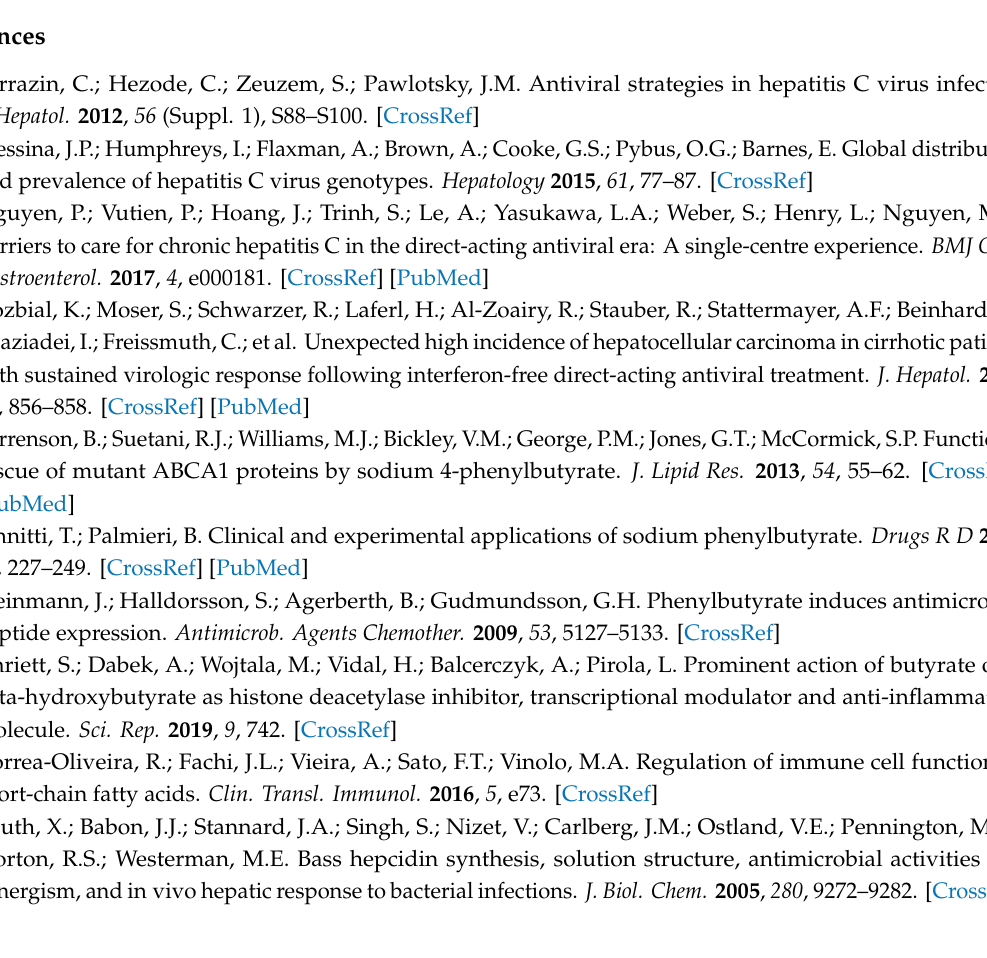
Figure S1: Anti-HCV e ff ect of 4-PBA has no relevant with ER stress scavenging and cell toxicity, Figure S2: 4-PBA induced MMV formation, Figure S3: 4-PBA disrupt MW component protein interaction, exogenously, Figure S4: Mouse body weight change after 4-PBA